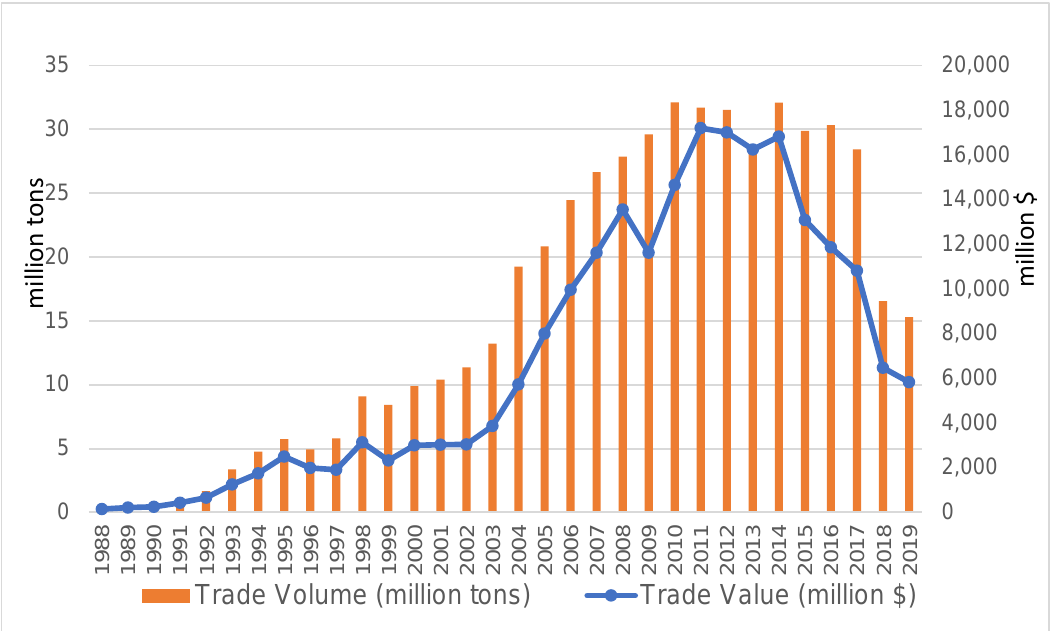
Figure 1. Global trade in plastic waste over time.